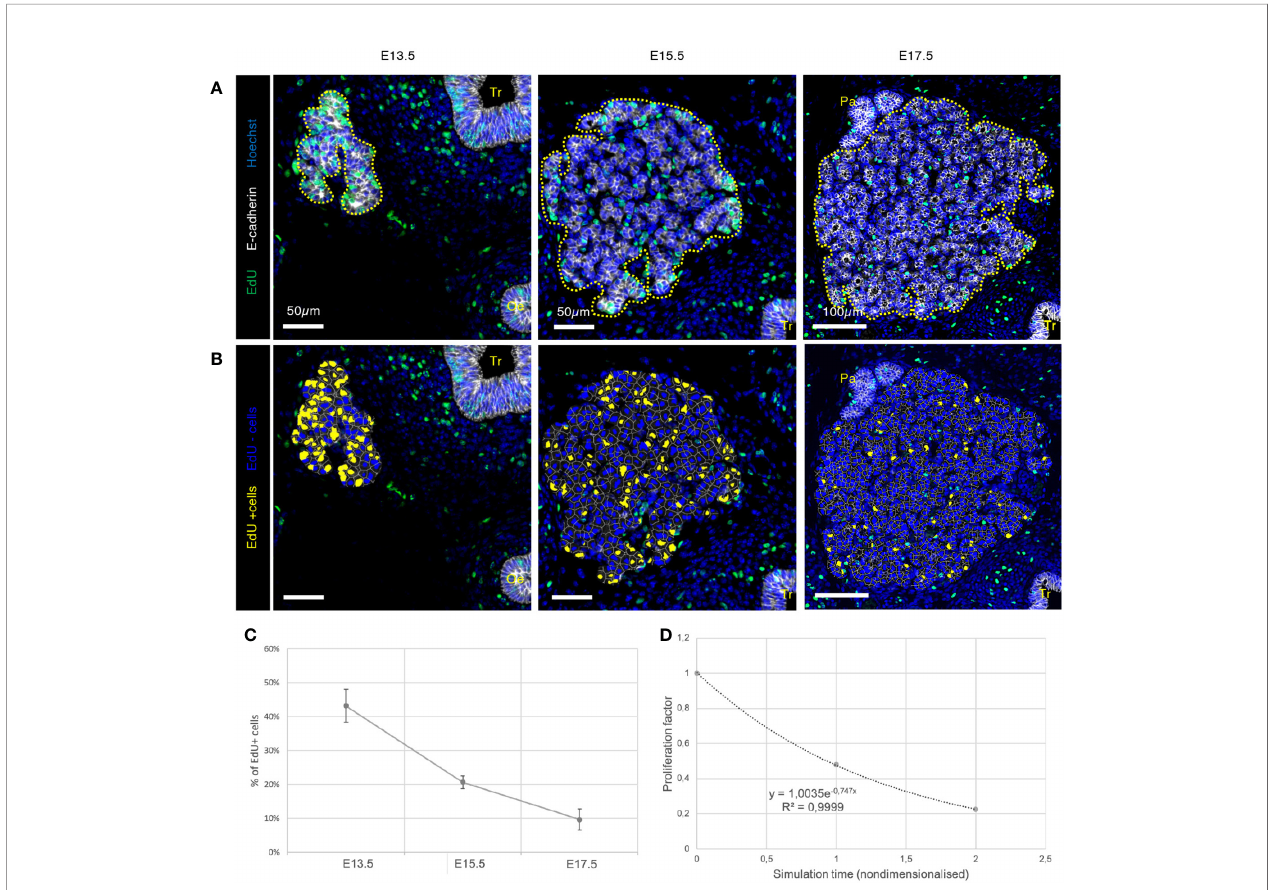
FIGURE 3 | Visualisation and quanti fi cation of proliferating cells in developing thyroid at the three different embryonic stages. (A) Immunolabelling of epithelial cells in white (E-cadherin) and proliferating cells in green (EdU). Nuclei are stained in blue (Hoechst). Tr, trachea; Oe, oesophagus; Pa, parathyroid. (B) EdU+ cells were coloured using HALO in yellow and EdU- cells in blue. (C) Percentage of EdU+ cells in the developing thyroid at the three embryonic stages (n = 3). (D) Proliferation factor of epithelial cells in the embryonic thyroid. Both axes are nondimensionalised by (y) dividing the percentage of EdU+ cells by the highest value (here at E13.5), and (x) replacing the embryonic days by the time elapsed between two observations (here